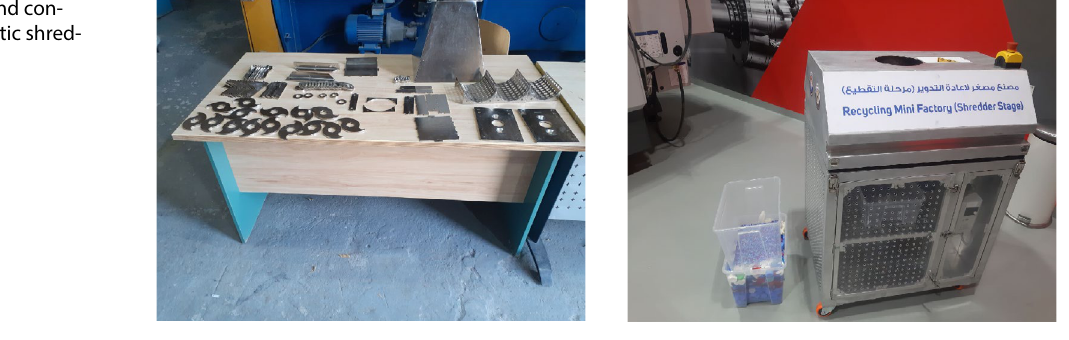
Fig. 8 Fabrication and con- struction of the plastic shred- der machine